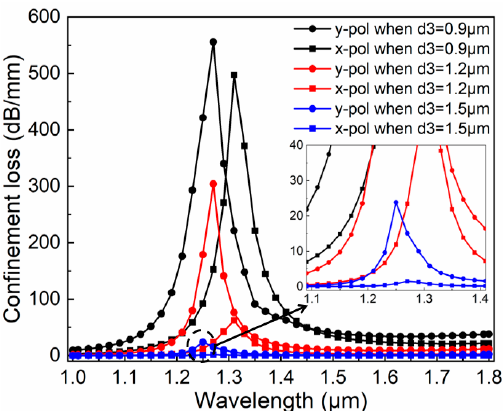
Figure 6. Dependence of transmission spectra in the x- and y-pol direction with different d 3 when d 1 is 1.2 μ m, d 2 is 2.2 μ m, and t is 100 nm.